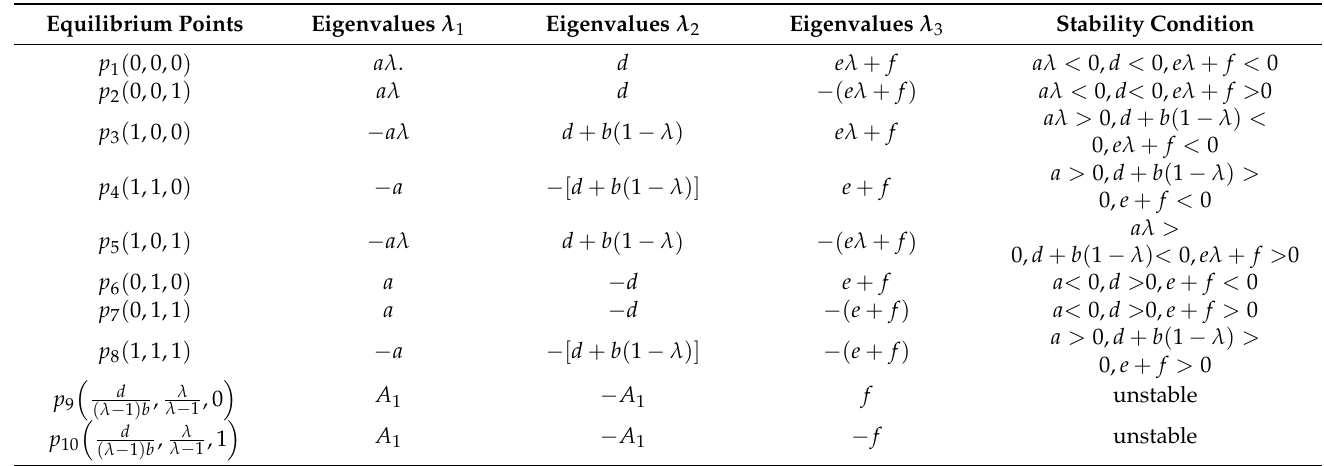
Table 3. Stability analysis of equilibrium